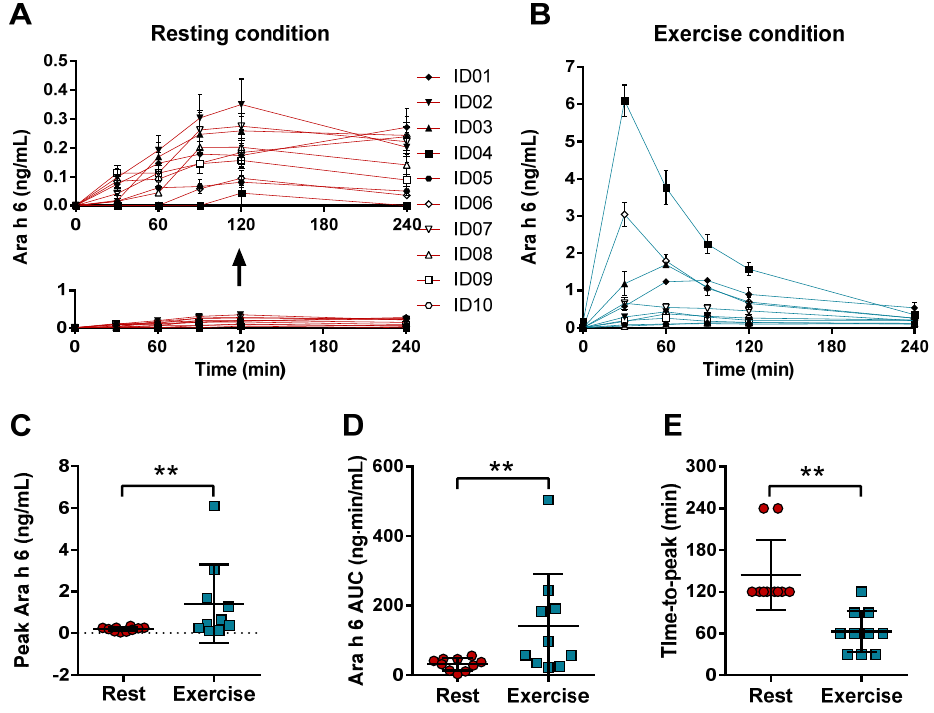
Figure 2. Ara h 6 levels in serum after peanut intake following rest or exercise. Serum levels of Ara h 6 (Mean ± standard deviation) was measured 30, 60, 90, 120, and 240 min after the consumption of 100 g of peanuts. This intake was followed by rest ( A , red lines ) or by exercise (60 min of cycling at 70% Wmax) ( B , blue lines ). For both conditions, individual peak levels ( C ), area under the curve (AUC) ( D ), and time-to-peak ( E ) were determined for rest (red circle) and exercise (blue square). ID represents an individual * represents a p -value < 0.05; ** represents a p -value < 0.01.